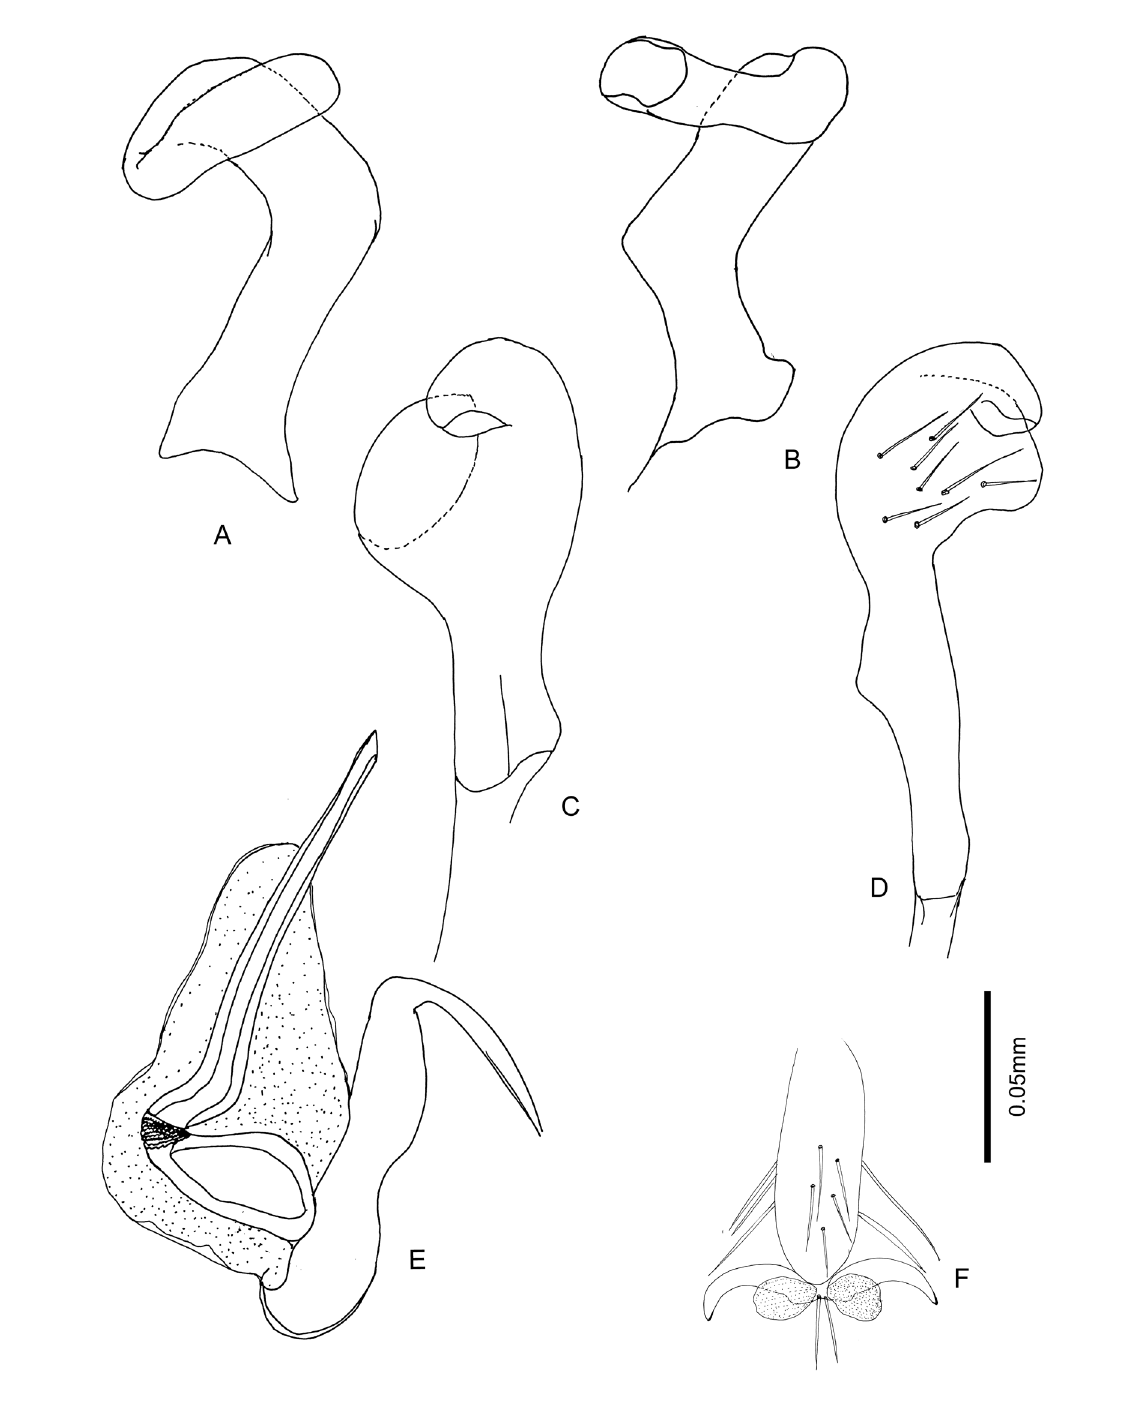
Fig. 20. Male genitalia and pretarsus of Mertila rubrocephala sp. nov., holotype, UASB. A–B . Right paramere in ventral and lateral views. C–D . Left paramere in ventral and dorsal views. E . Aedeagus in lateral view. F .